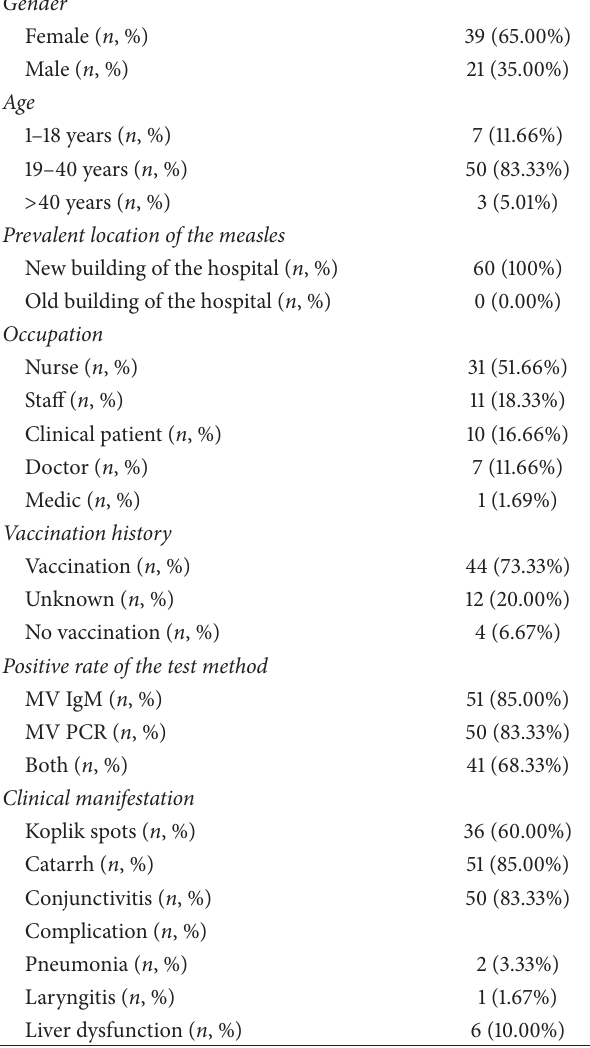
Table 1: Summary of cases diagnosed with measles in the outbreak.